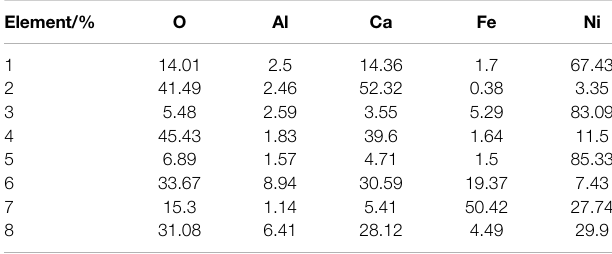
TABLE 4 | EDS of Fe doped catalysts.